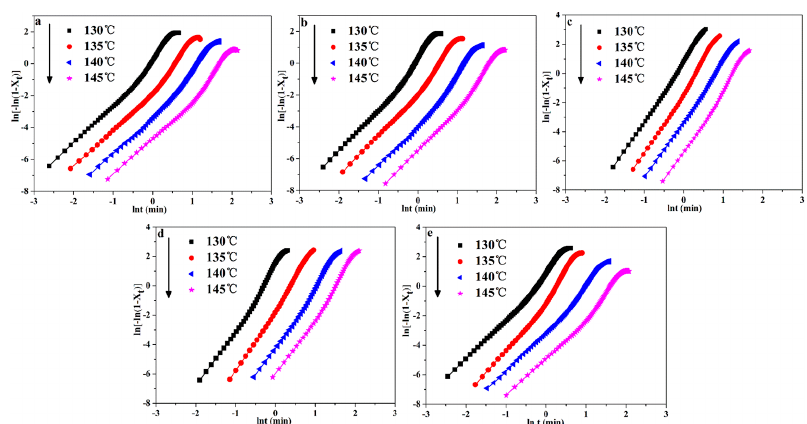
( c ) POM-2, ( d ) POM-3 and ( e ) POM-4.